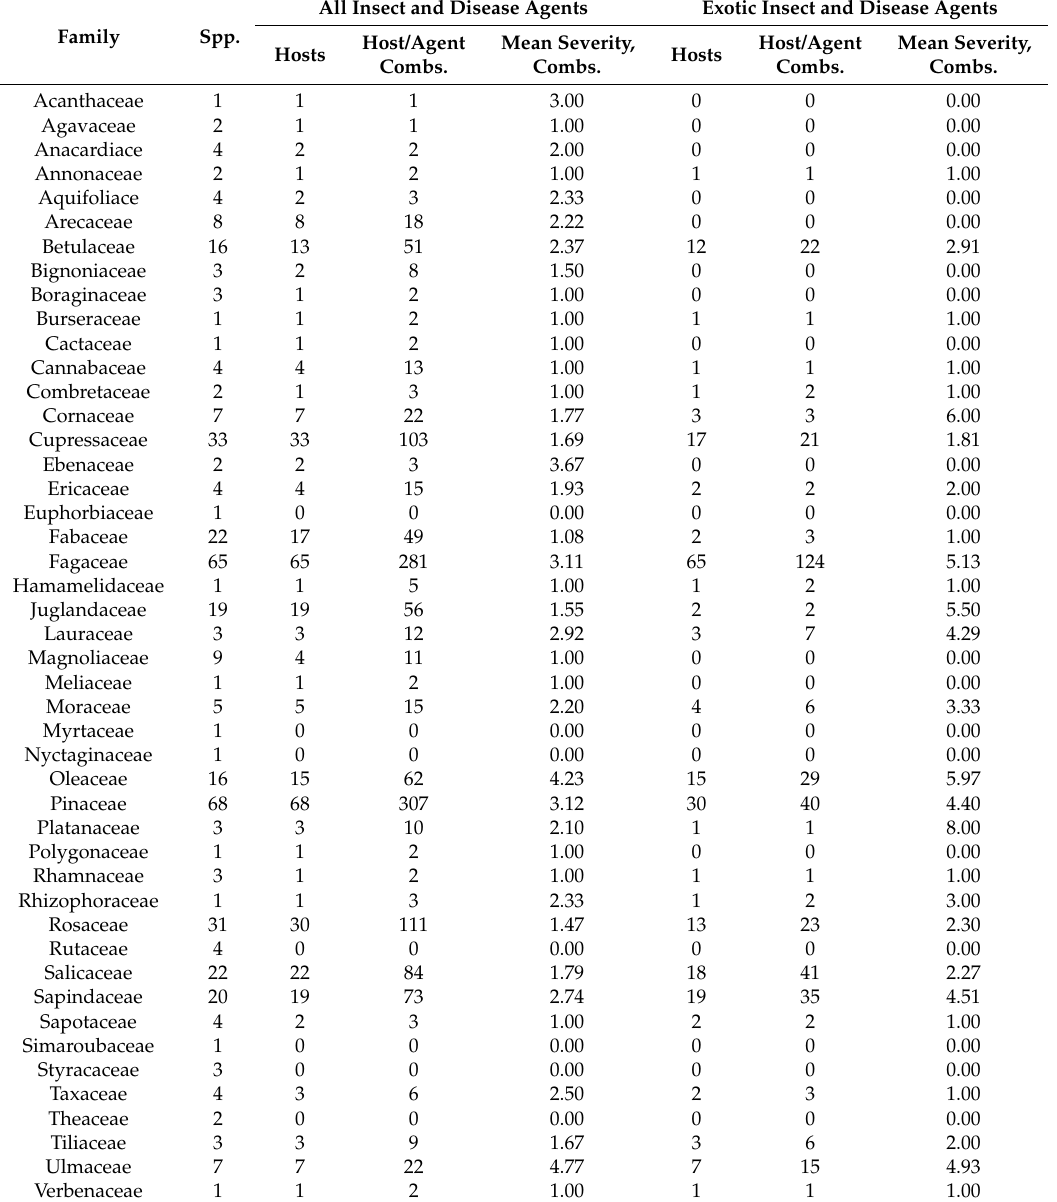
Table 1. Number of hosts, number of host/species combinations, and mean severity of those combinations, by host species family, for all insect and disease agents and for exotic insect and disease agents. Family Spp.